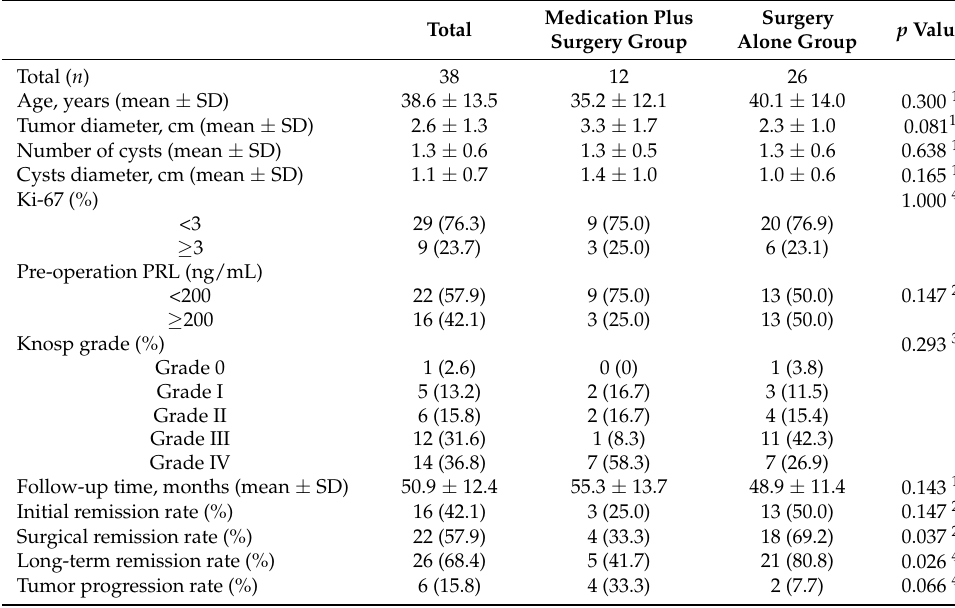
Table 6. Baseline characteristics of two different treatment groups with cystic pituitary prolactin- secreting macroadenomas. Total